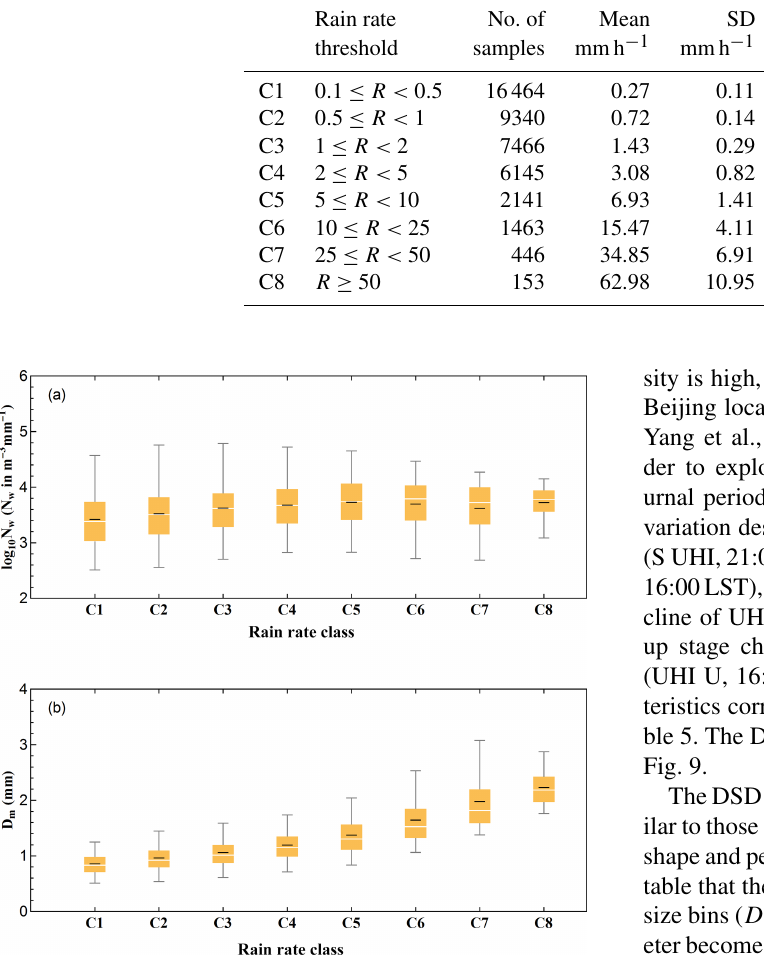
Figure 8. Variation of the normalized intercept parameter log 10 N w (a) and the mass-weighted mean diameter D m (b) for dif- ferent rain rate classes. The white central line of the box indicates the median, the black central line in the box indicates the mean val- ues, and the bottom and top lines of the box indicate the 25th and 75th percentiles, respectively. The bottom and top lines of the ver- tical lines out of the box indicate the 5th and 95th percentiles, re-